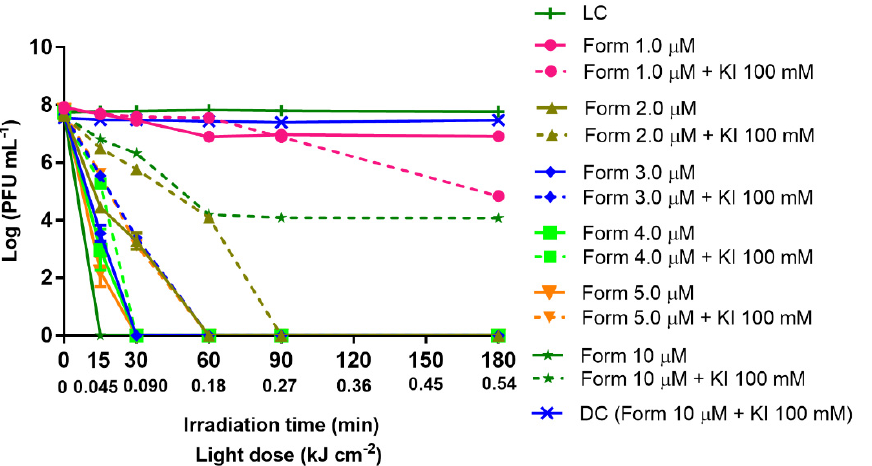
Figure 3. Inactivation of T4-like bacteriophage during aPDT, in filtered WW (0.45 µm pore size filtration) with Form at different concentrations (1.0, 2.0, 3.0, 4.0, 5.0, and 10 µM) alone and in combination with KI (at 100 mM), for 180 min of irradiation with white light (50 mW cm − 2 ). The values are expressed as the mean of three independent experiments; error bars represent the standard deviation (SD) between the experiments; to note, in some cases, SD bars are covered behind the symbols and lines just join the experimental points.